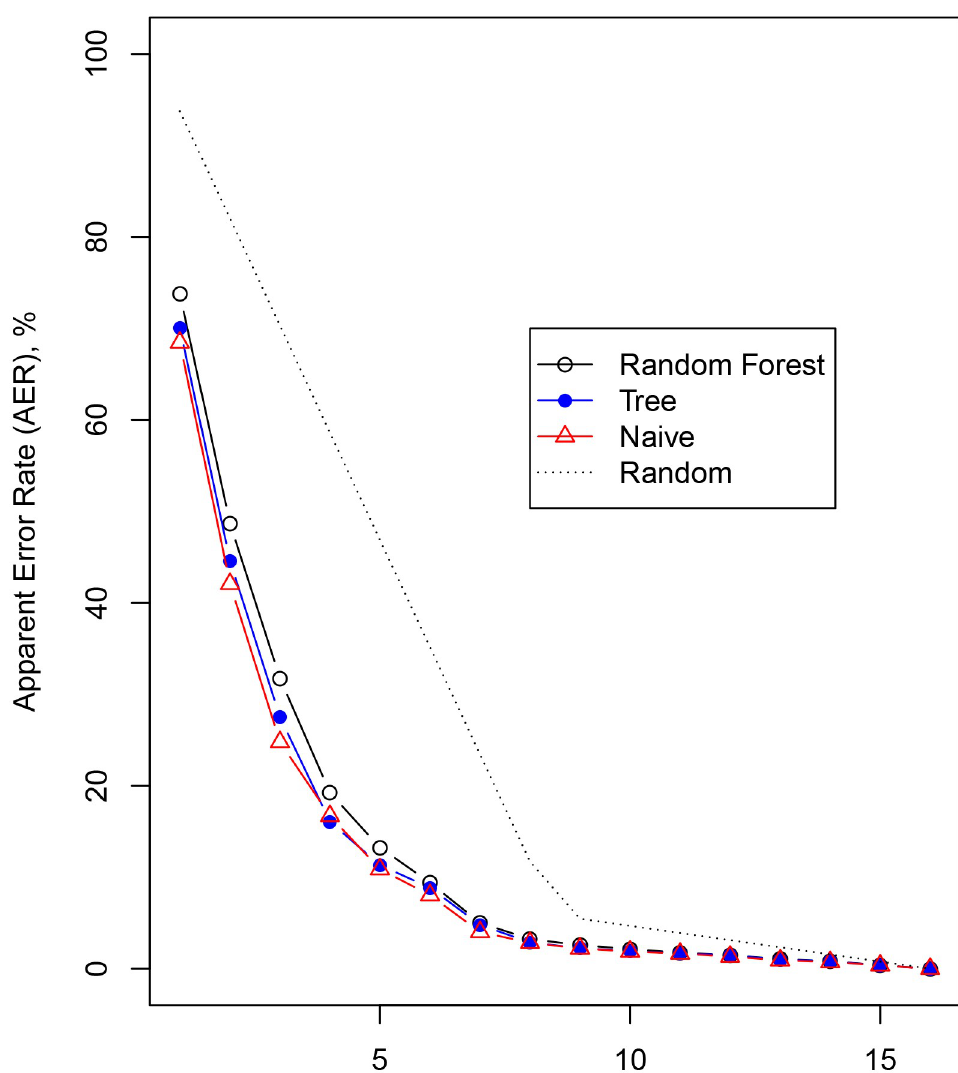
Fig 8. The apparent error rate (AER) to within 1,2, etc. categories for the percentage-to-sentence responses with the likelihood prompt. The categories are arranged as in Fig 6.